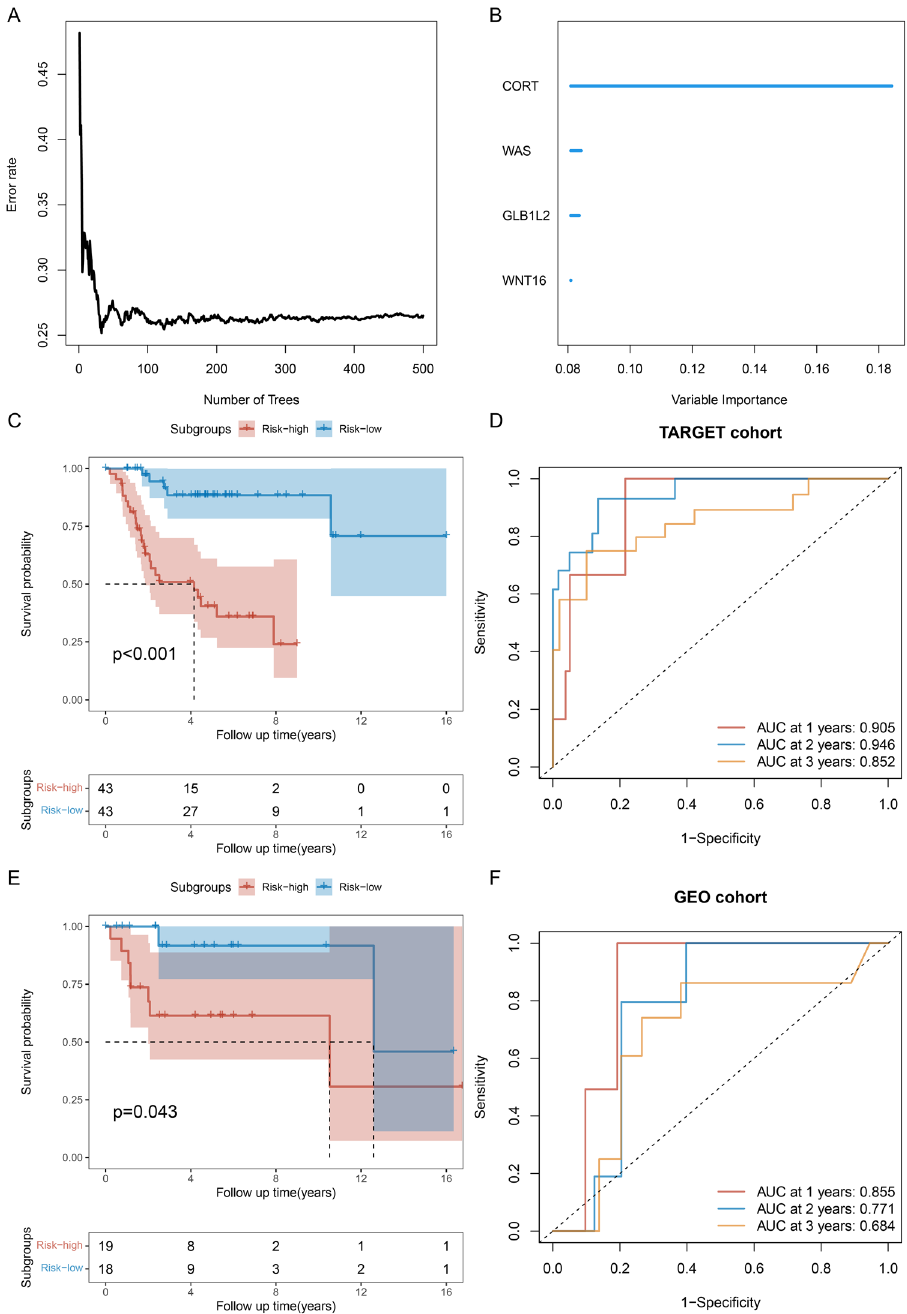
Figure 6. Random forest prediction model construction based on WAS, CORT, WNT 16 and GLB1L2 eigengenes. ( A ) Training process of the random forest. ( B ) Eigengene importance ranking, importance from large to small order CORT, WAS, GLB1L2 and WNT 16. ( C ) Random forest prediction score based on the TARGER-OS dataset. ( D ) Time-dependent ROC curves were drawn based on the random forest prediction scores of the TARGER-OS dataset. ( E ) Random forest prediction score based on the GSE39055 dataset. ( F ) Time-dependent ROC curves were drawn based on the random forest prediction scores of the TARGER-OS